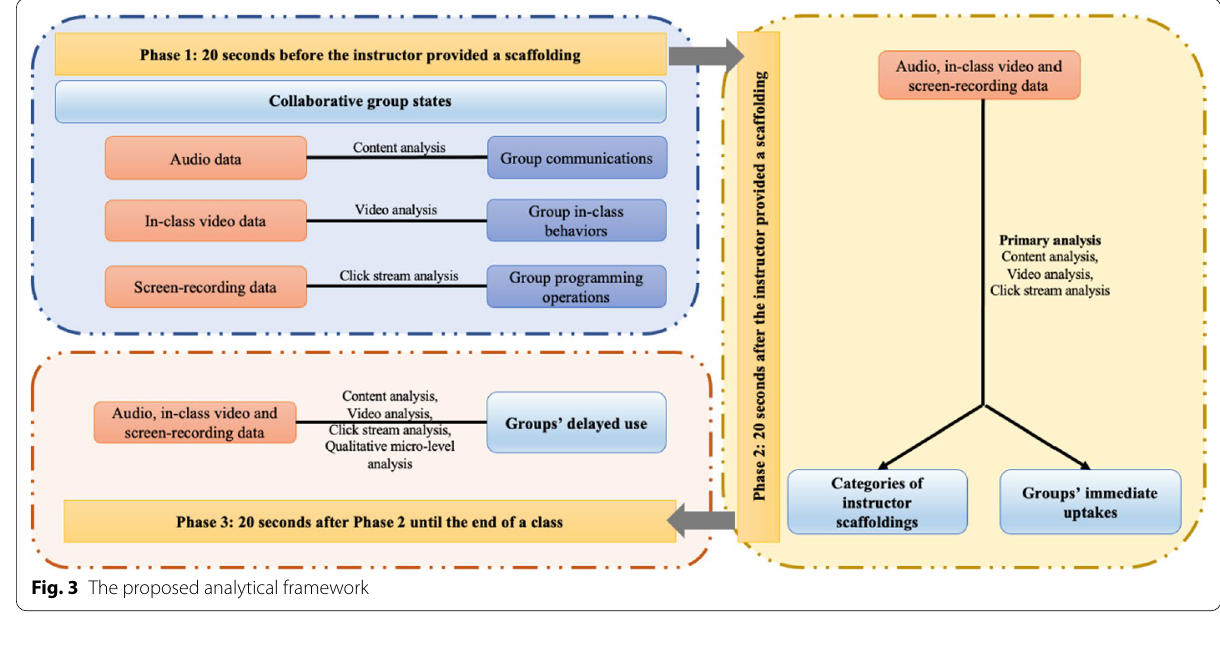
Fig. 3 The proposed analytical framework